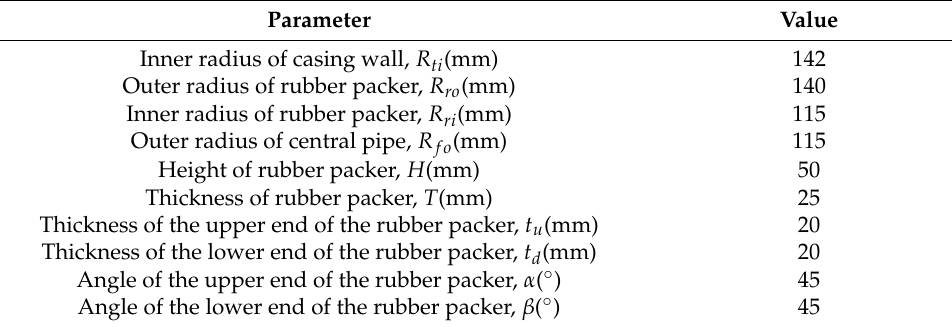
Figure 2. Model of the sealing position. ( a ) Two-dimensional axisymmetric numerical model; ( b ) Cross-sectional view of rubber packer. Table 1. Structural parameters of numerical model.